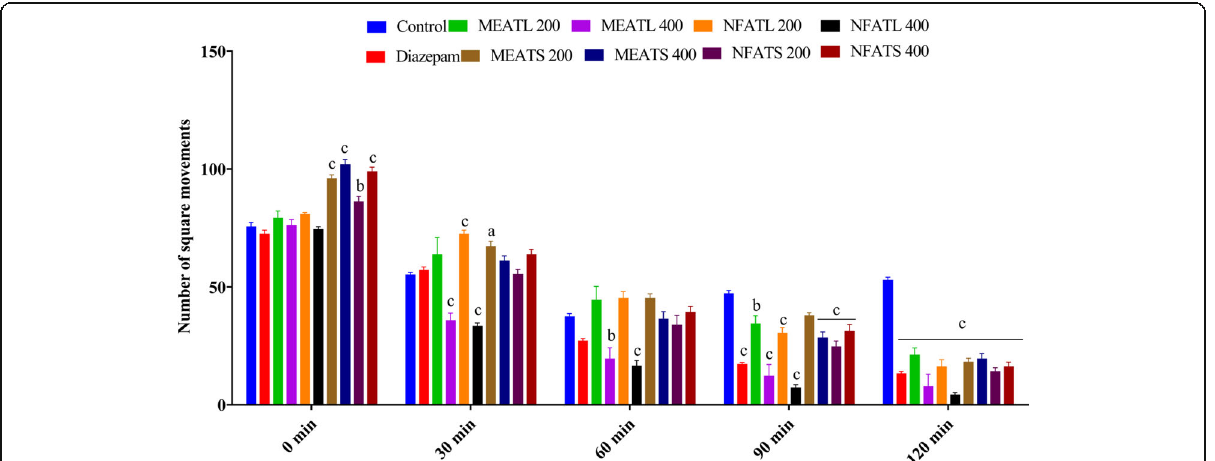
Fig. 1 Locomotor activity of different extracts of A. trilobata on open field test in mice. The results were expressed in mean ± SEM, where a p < 0.05, b p < 0.01 and c p < 0.001 were considered as statistically significant. The statistical analysis followed by one-way analysis of variance (Dunnett ’ s test) compared to the negative control (1% Tween-80) using GraphPad Prism version 8.4. MEATL, methanol extract of A. trilobata leaves; NFATL, n-hexane fraction of A. trilobata leaves; MEATS, methanol extract of A. trilobata stem; NFATS, n-hexane fraction of A. trilobata stem